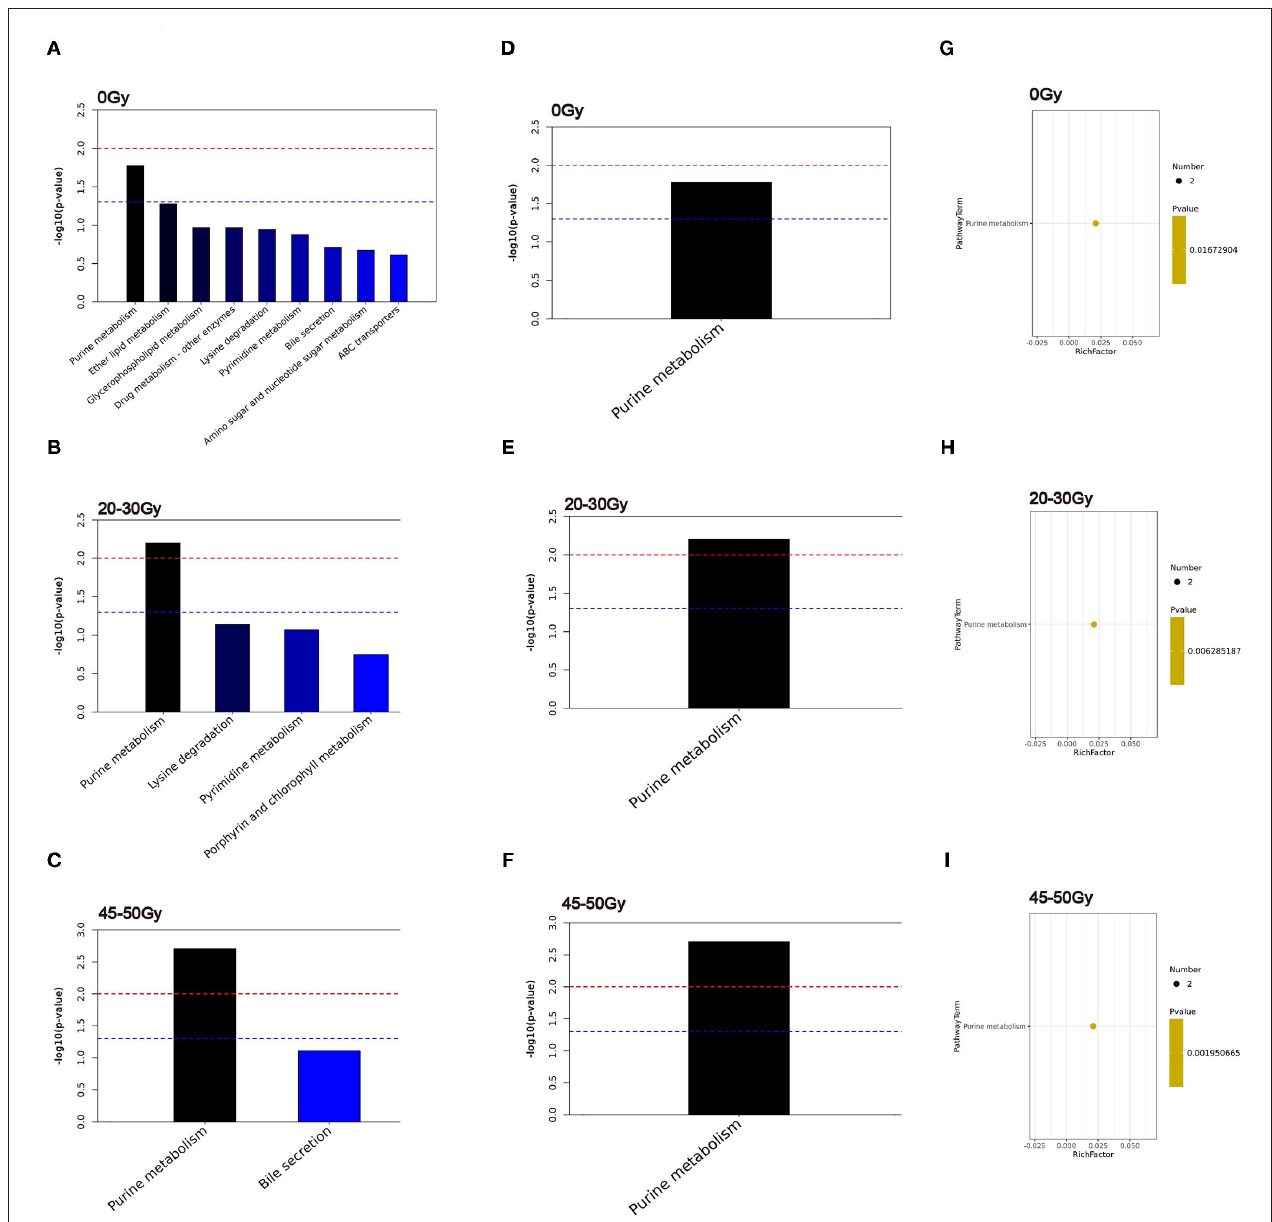
FIGURE 4 | Identification of significantly different pathways associated with RIII. (A–C) The top 20 enriched pathways. (D–F) Heatmap of enriched metabolic pathway. (G–I) bubble plots of enriched metabolic